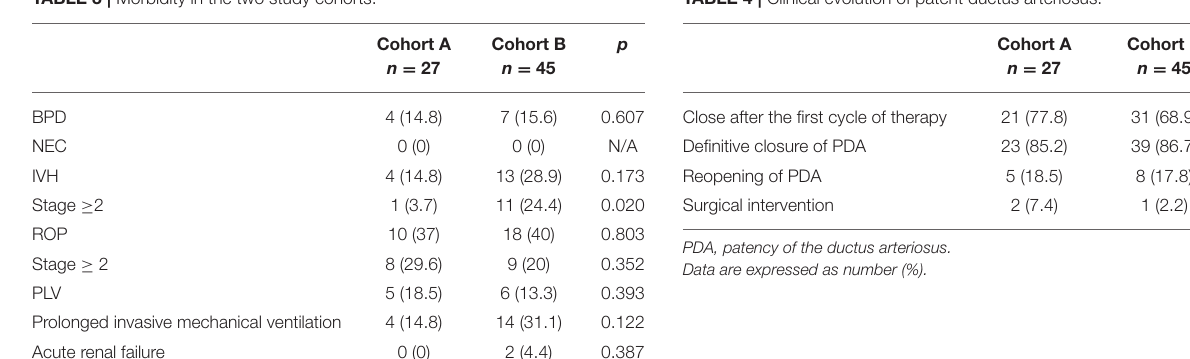
TABLE 3 | Morbidity in the two study cohorts. TABLE 4 | Clinical evolution of patent ductus